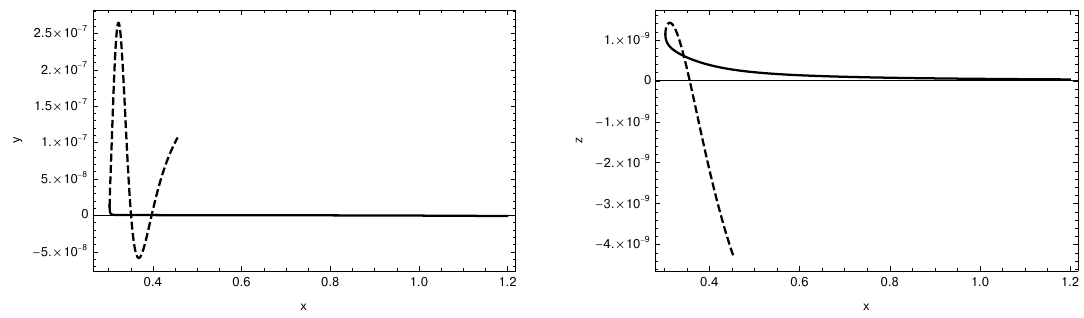
Figure 8 . Numerical checks of the (cid:12)rst law of thermodynamics d E = Tds (left panel, (cid:12)xed B and m ) and the basic thermodynamic relation F = (cid:0) P L (right panel) in the n CFT m model with p m = 2 B . The dashed parts of the curves indicate thermodynamically unstable branches of the